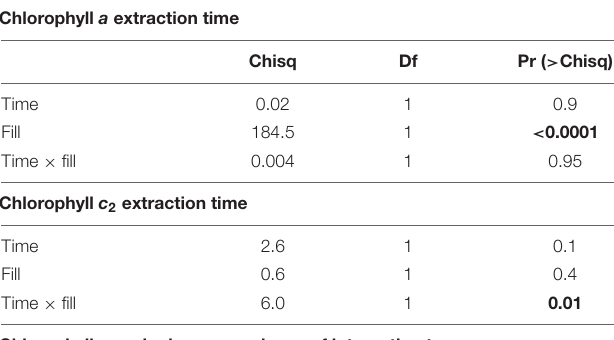
TABLE 1 | Generalised linear mixed model results of extraction time of chlorophylls a and c 2